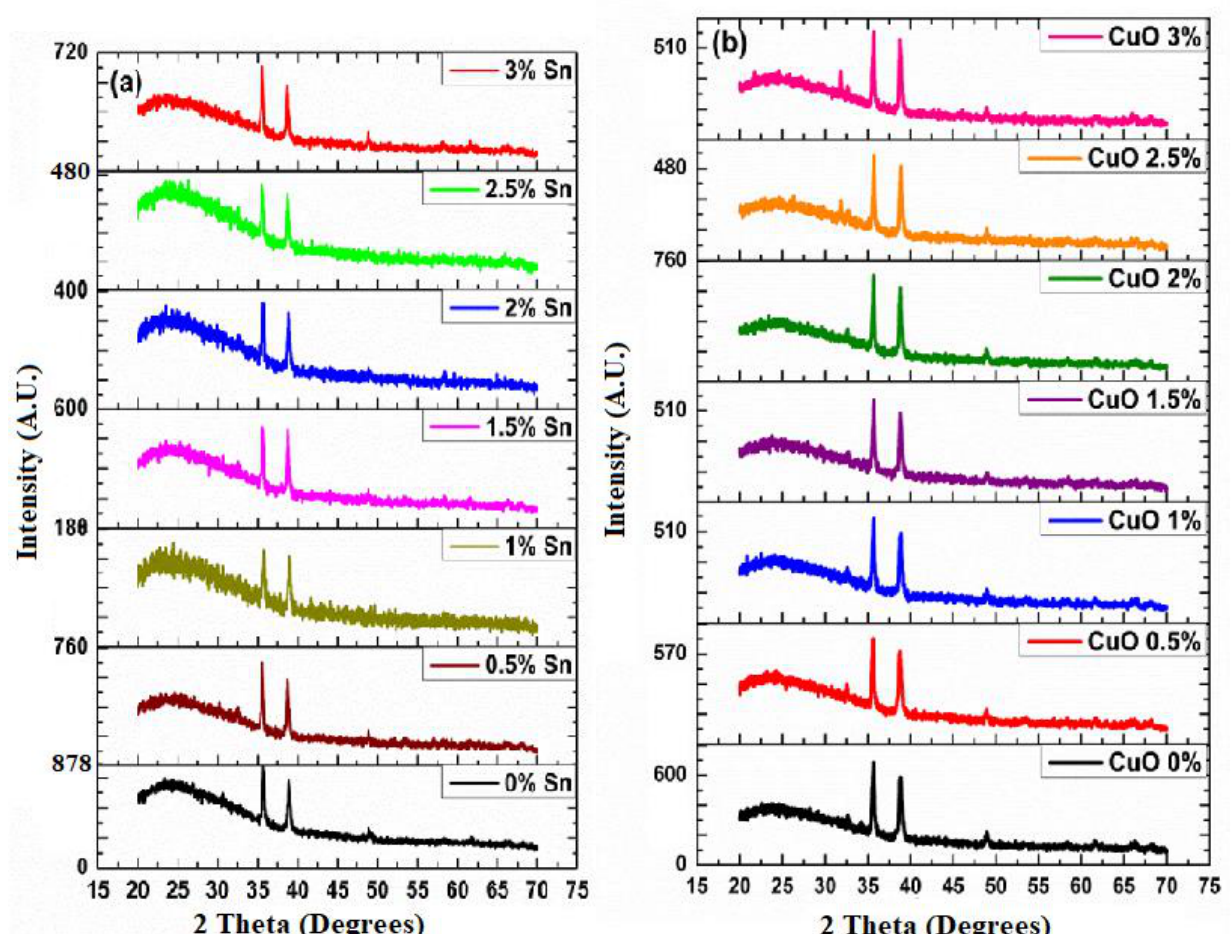
Figure 1. XRD patterns measured for CuO thin films with various Sn doping concentrations. ( a ) 5- and ( b ) 10-layered.